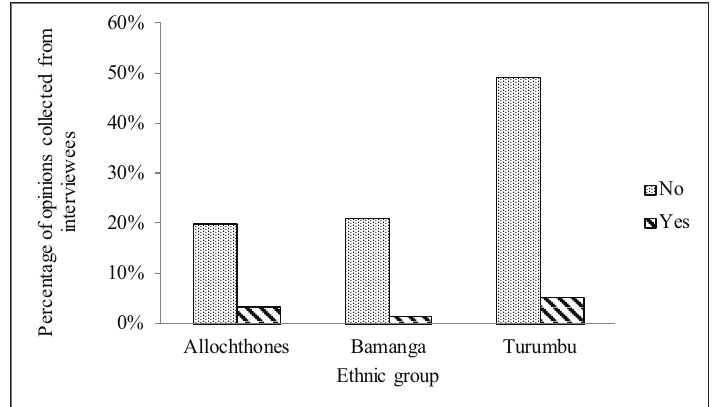
Figure 3. Opinion on awareness raising on conservation in Yangambi Biosphere Reserve management.